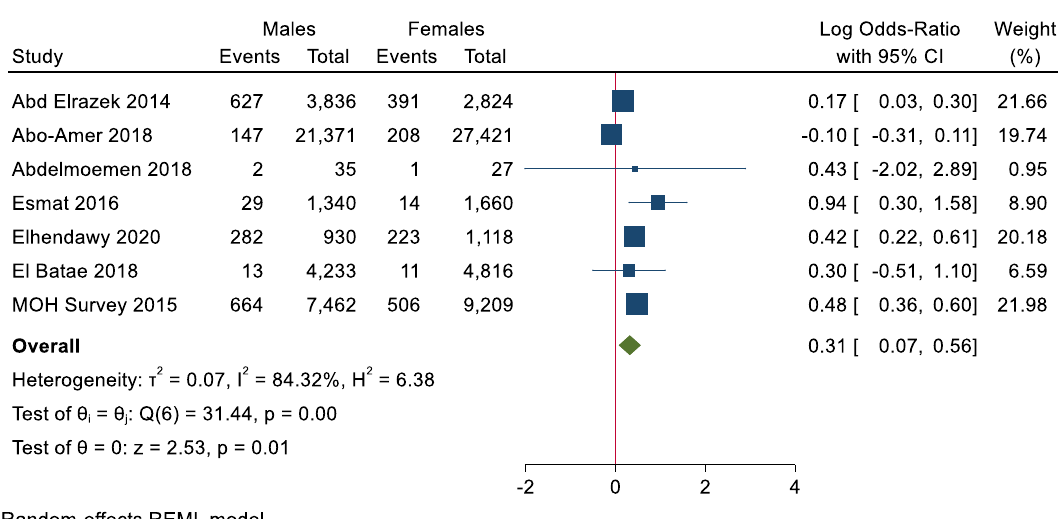
Figure 6. Forest plot of seroprevalence of HCV antibodies in males and females in adults. There is no significant difference in seroprevalence of HCV antibodies between males and females in adults.